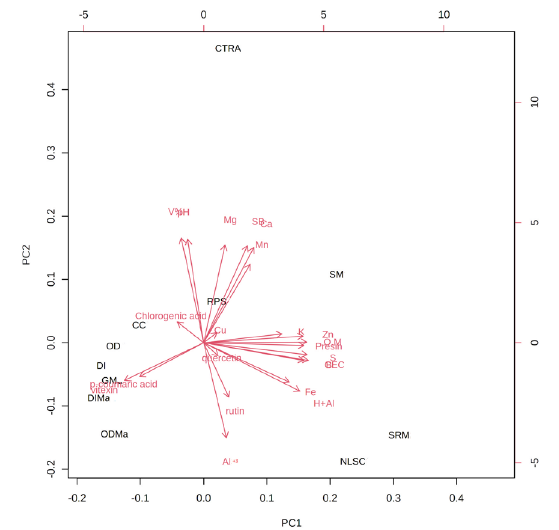
Figure 5. Biplot of principal component analysis (PCA) for soil and climate factors and phenolic constituents of L. pinaster population samples. Figure 6. Importance of soil and climate variables in